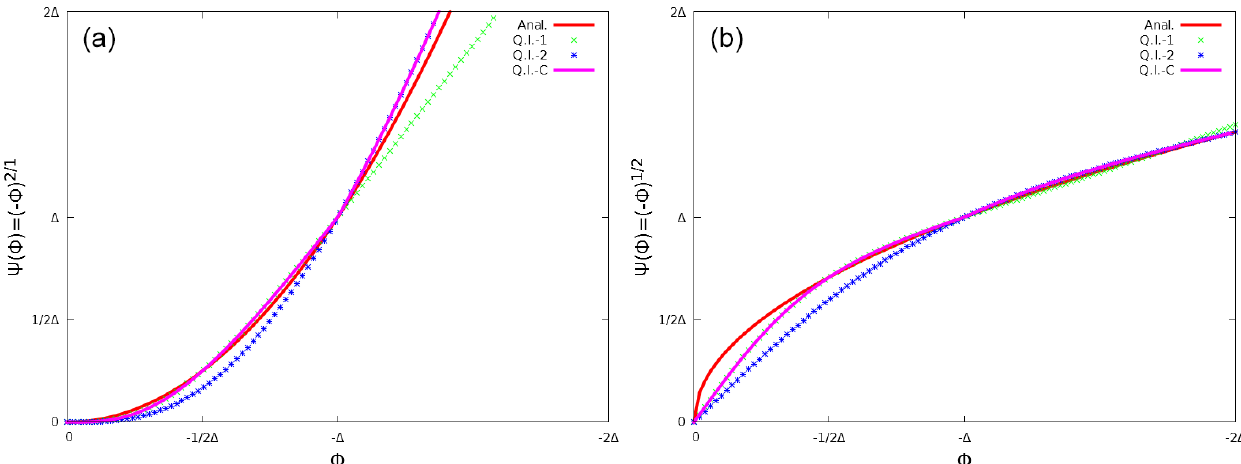
Figure 4. Profile normal to the interface of two points of fluid information ψ : analytical solution (red lines), quadratic interpolation QI 1 using ψ − φ =[ 1 / 2 ; 1 ] (cid:49) (green symbols), QI 2 using ψ − φ =[ 1 ; 2 ] (cid:49) (blue symbols), QI C as a combination of QI 1 and QI 2 (purple lines).